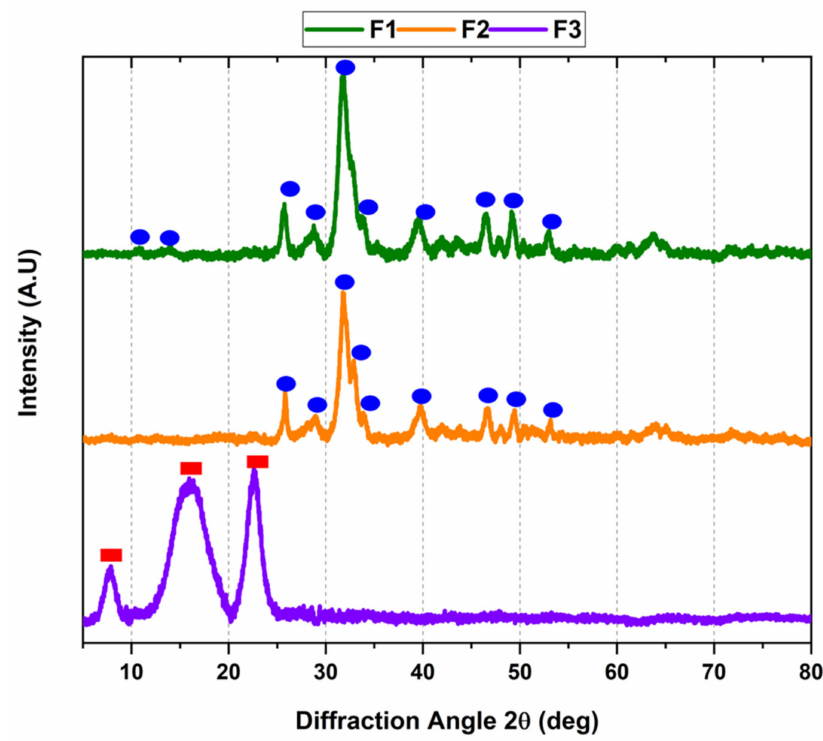
Figure 3. XRD diffraction pattern of F1, F2, and F3. F1: InterOss. F2: InterOss Collagen. F3: InterCol- lagen